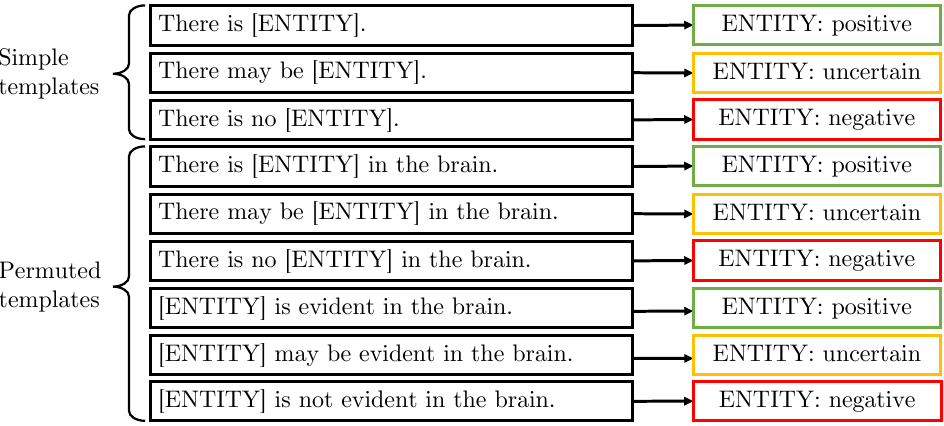
Figure 4. These are the “generic” templates which aim to provide an example for every entity class (simple templates) with entities at different positions in the sentence (permuted templates).